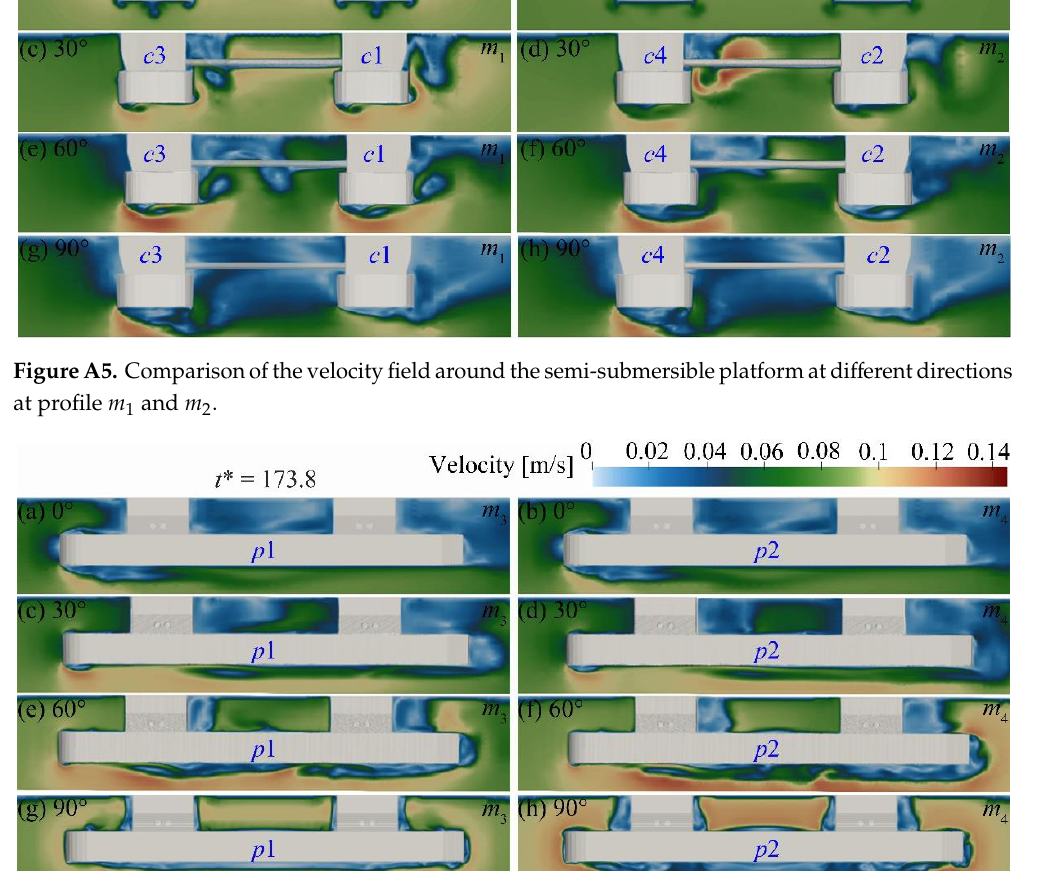
Figure A6. Comparison of the velocity field around the semi-submersible platform at different angles at profile m 3 and m 4 .